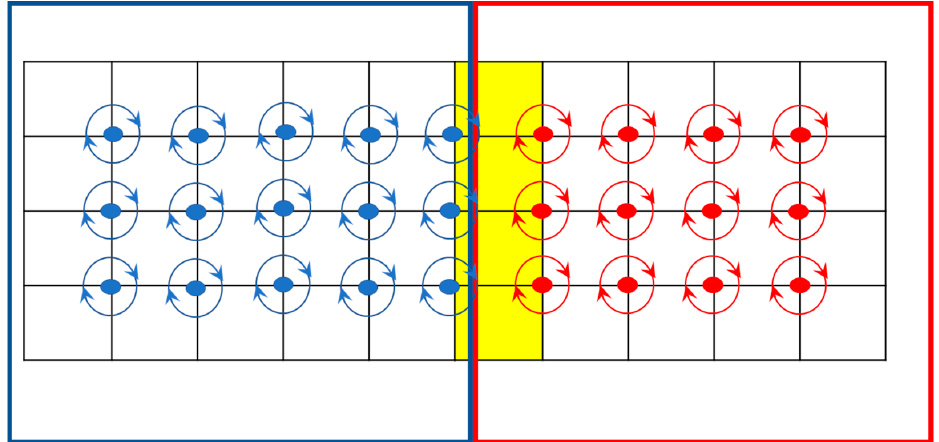
Figure 8. The DOF-based approach. Each box contains its own DOFs, here marked in red and blue. The elements belonging to the interface between the two boxes, require to be replicated in the box– box matrix